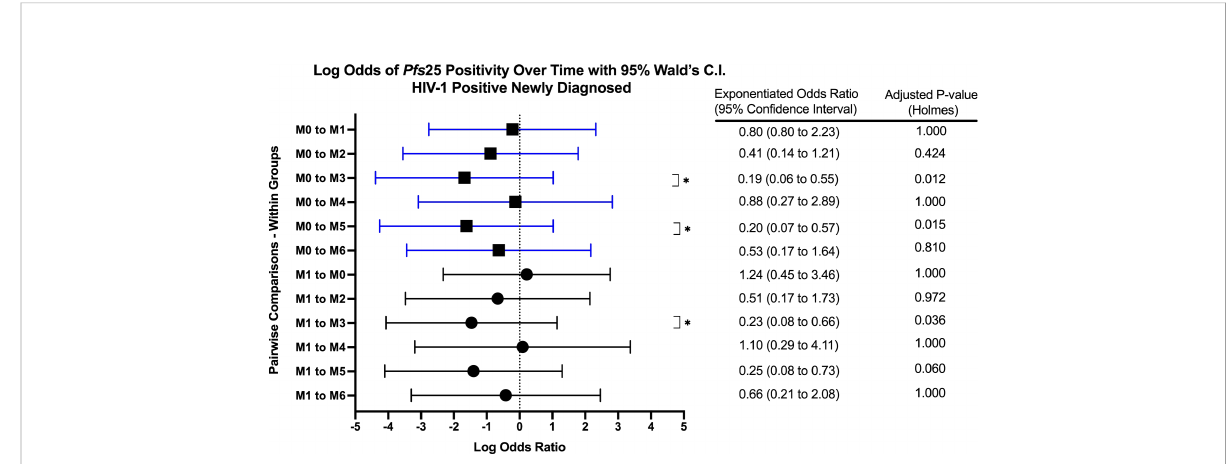
FIGURE 5 Forest Plot of the Log Odds of Pfs25 Positivity in HIV-1 Positive Newly Diagnosed Volunteers. The log odds and accompanying exponentiated adjusted odds ratio of being positive for at least one gametocyte-speci fi c transcript within the HIV-1 positive newly diagnosed study group between month 0 (M0) and between month 1 (M1). P-values were adjusted using the Holm ’ s method for multiple comparisons. Blue con fi dence interval lines are comparisons with month 0 and black con fi dence interval lines are comparisons with month 1.